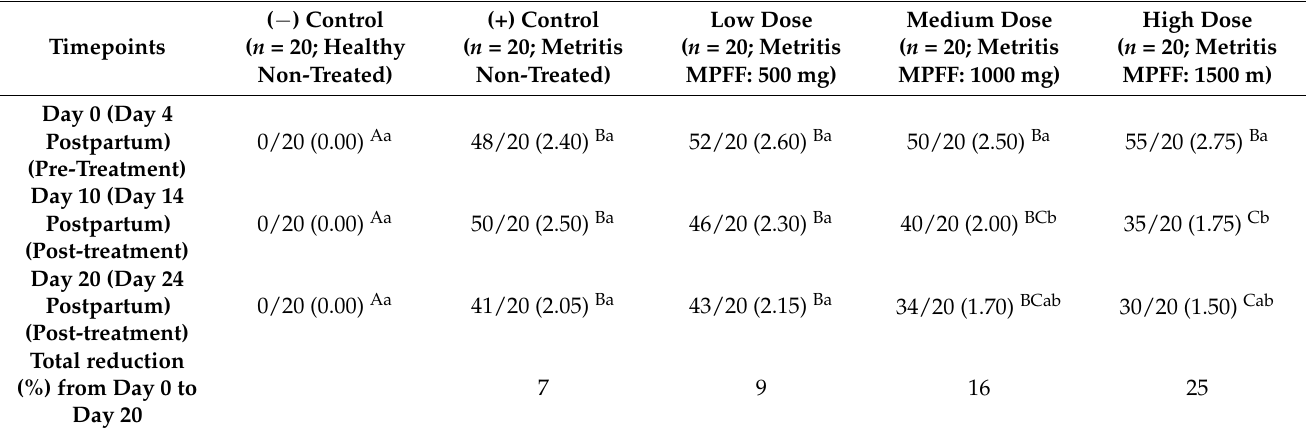
Table 6. Effects of intrauterine infusion of Micronised Purified Flavonoid Fraction (MPFF; low, medium and high concentrations) on the number of pathogenic bacterial isolates on days 0, 10 and 20 (days 4, 14 and 24 postpartum, respectively) in metritis-diagnosed dairy cows naturally infected by E. coli during the early postpartum